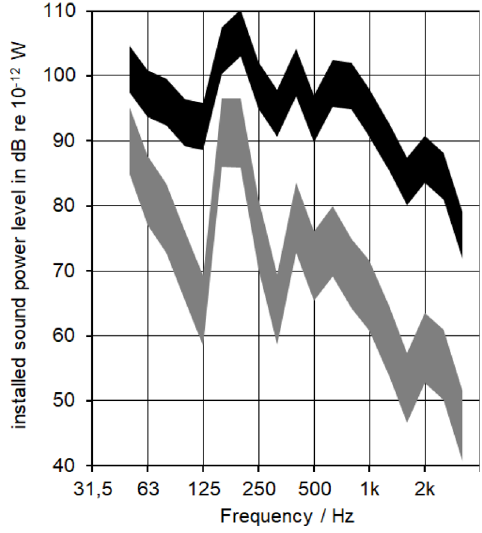
Figure 23. Sixty eight percent con fi dence intervals of the predicted installed sound power level of the round robin reference source when it is connected to a low mobility receiver ( Y = 10 (cid:3) 5 m/(s N), black) and a high mobility receiver ( Y = 10 (cid:3) 2 m/(s N), grey) under the assumption u ( L Re( YR ) ) = u ( L ( YR / YS ) ) = 2.0